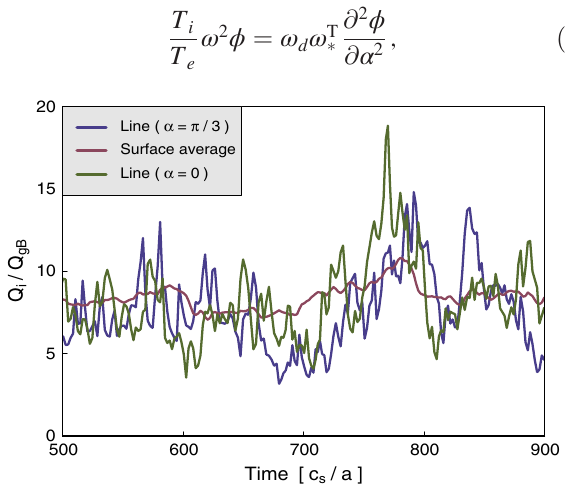
FIG. 4. Ion heat flux (in gyroBohm units) caused by ITG ¼ 2 ) on the magnetic surface of a tokamak in turbulence ( 1 =L T i the small- ρ (cid:3) regime. The time traces correspond to two different magnetic field lines and the surface average, all exhibiting almost the same transport level.